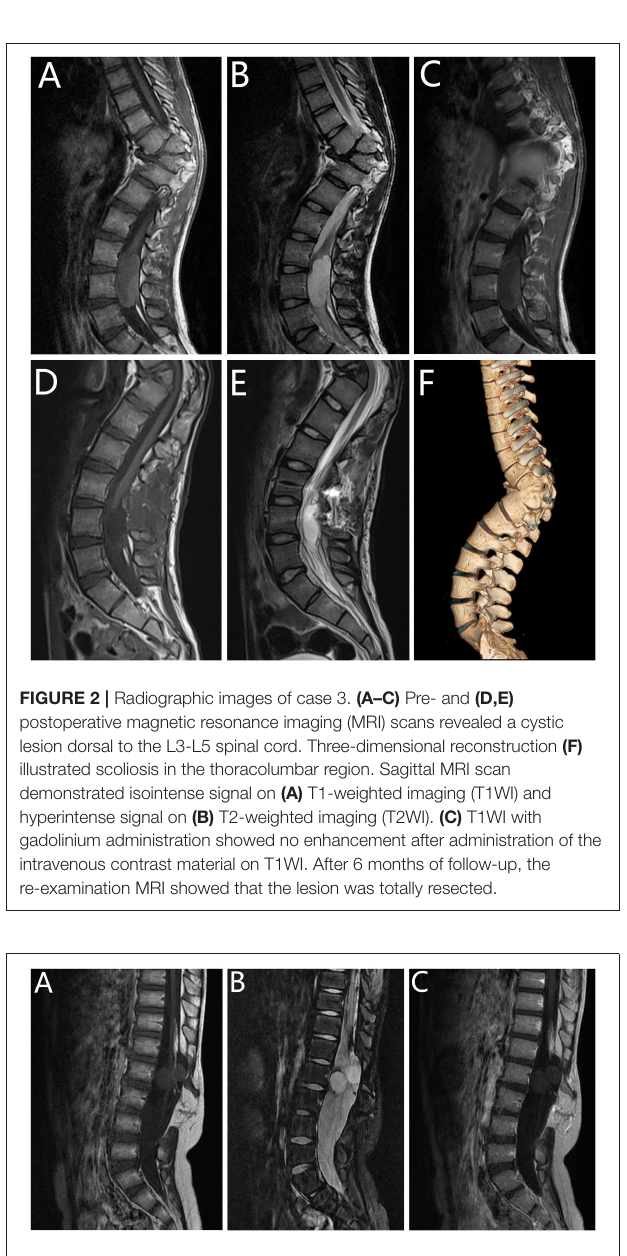
FIGURE 3 | Radiographic images of case 9. Preoperative (A–C) magnetic resonance imaging (MRI) scans revealed two cystic lesions to the L1 spinal cord. This patient had tethered cord syndrome (with spina bifida and myelomeningocele). Sagittal MRI scan demonstrated Hypointense signal on (A) T1-weighted imaging (T1WI) and hyperintense signal on (B) T2-weighted imaging (T2WI). (C) T1WI with gadolinium administration showed no